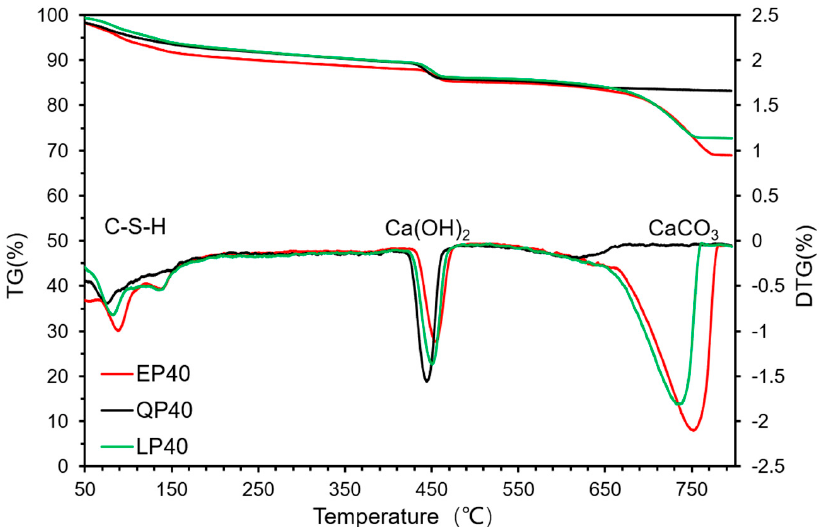
Figure 15. Thermal decomposition of EP40, QP40 and LP40 by TGA–DTG analyses at 28 d.